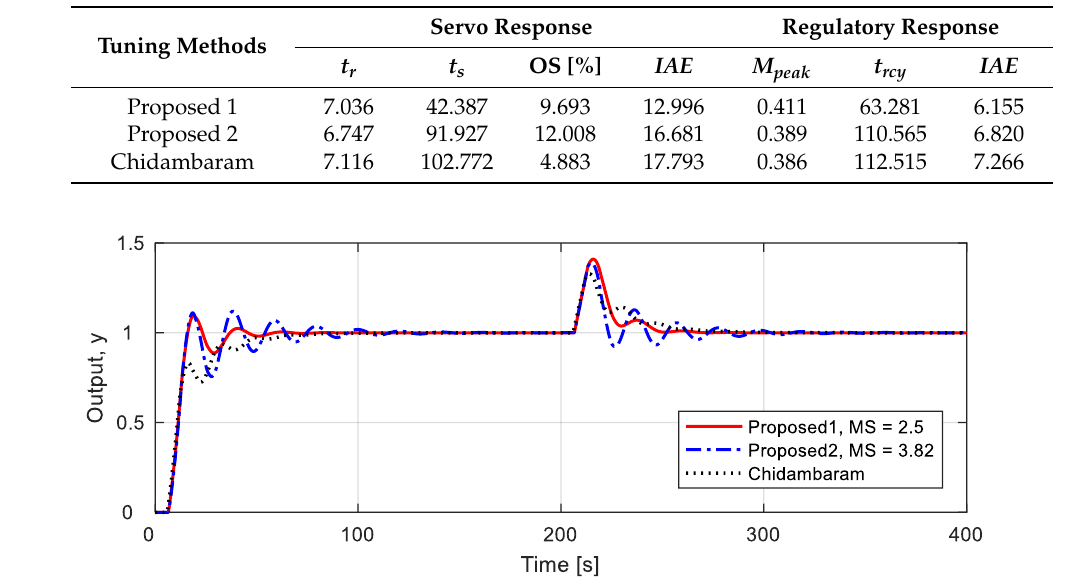
Table 8. Performance comparisons for nominal process 𝑃 3 .